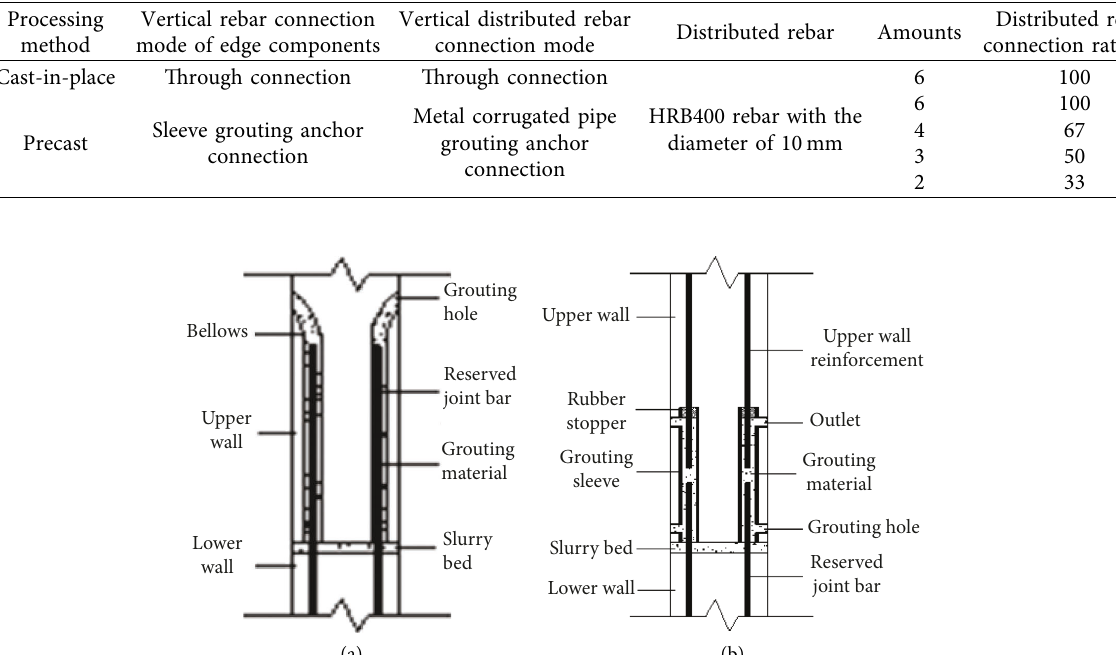
Table 2: Design parameters of specimen.